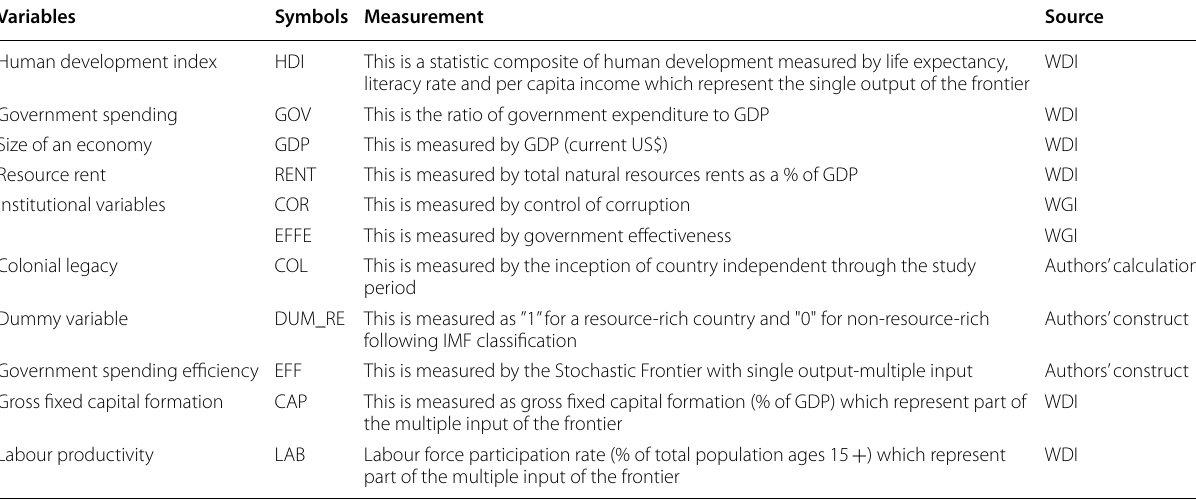
Table 2 Data and Sources. Source Authors Compilation (2022)